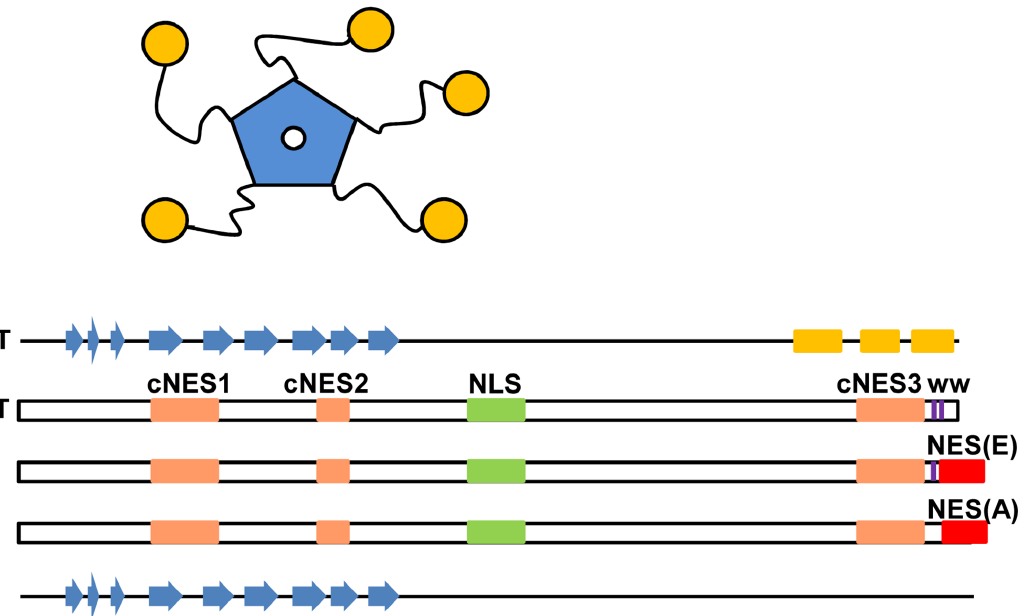
Fig 1. Schematic representation of NPM structure indicating the location of subcellular targeting motifs. (A) Schematic drawing of pentameric NPM, with core domain depicted in blue and C-terminal domains in yellow. (B) Position of candidate NES motifs (cNES) in NPM, in orange (cNES1 (42 – 61) [18], cNES2 (94 – 102) [3], and cNES3 (268 – 278) (this study)) and of acquired NES in AML-associated mutants A and E, in red. NLS (141 – 157) [3], in green, and the two Trp residues related to nucleolar targeting (288 and 290 [16], in purple) are also indicated. The secondary structure assignment of wild type NPM and mutant A are shown, β -strands denoted as blue arrows and α -helices as yellow cylinders. Mutant A is supposed to lack C-terminal helical structure, while mutant E would partly retain it [11].